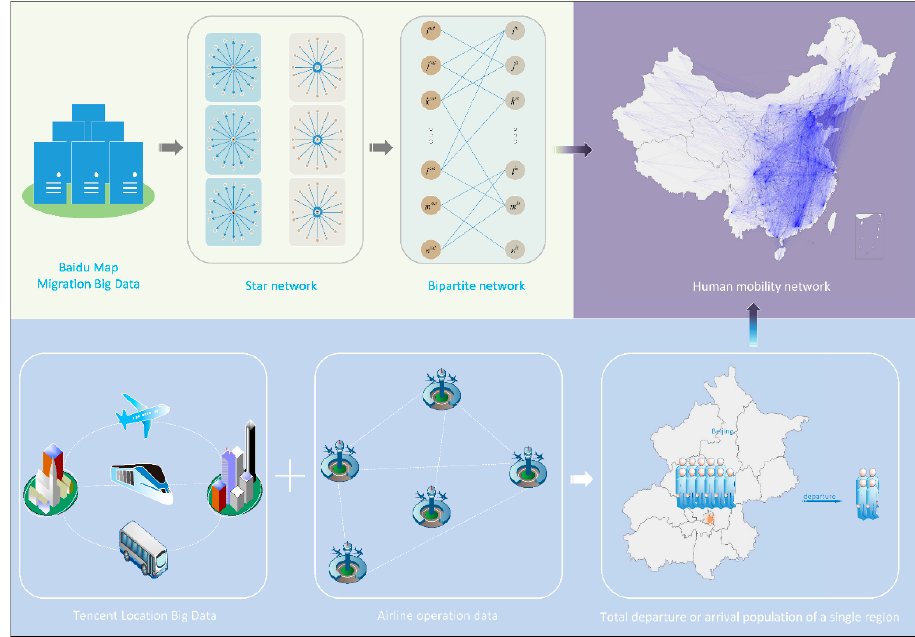
Figure 1. Overview of the data and model framework.